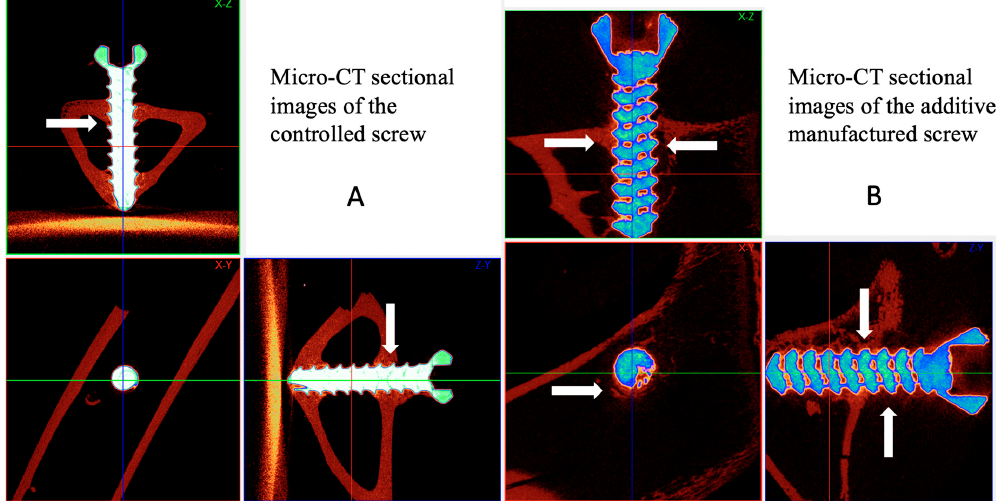
Figure 4. Micro-computed tomography (Micro-CT) examination. Comparison of micro-CT sectional images ( A and B ) between the interference screws. Micro-CT revealed woven bone formation between the AMD screw and bone tunnel in all sectional images. The AMD screw was fixed in the bone tunnel with massive bone ingrowth from the cancellous bone of the proximal tibia. Line arrows mark the woven bone